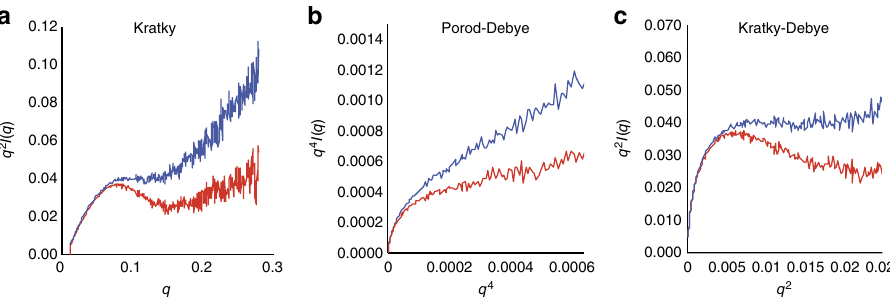
Figure 6 | Phosphorylation stiffens the CTD. ( a ) Kratky Plot ( q 2 (cid:3) I ( q ) versus q ) of averaged apo (blue) and phospho (red) MBP-CTD scattering curves. The more gradual rise in the high q region of the plot for the phospho-CTD than the apo-CTD indicates that the phospho-CTD is less flexible than the apo CTD. ( b , c ) Porod–Debye ( q 4 (cid:3) I ( q ) versus q 4 ) and Kratky Debye ( q 2 (cid:3) I ( q ) versus q 2 ) plots of the apo (blue) and phospho (red) scattering curves. The increased rise in the Porod-Debye plot for the apo-CTD compared to phospho-CTD indicates a phosphorylation dependent decrease in flexibility, as does the loss of the plateau in the Kratky–Debye plot for